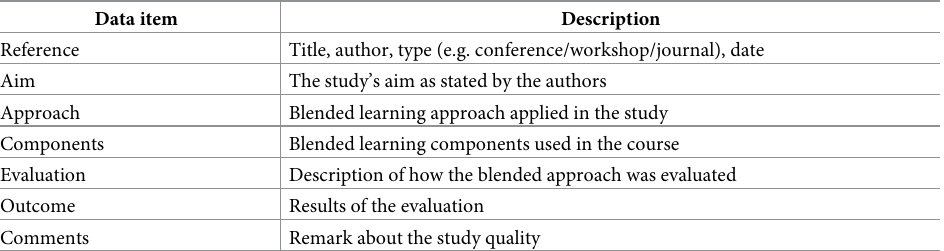
Table 2. Data extraction form items.